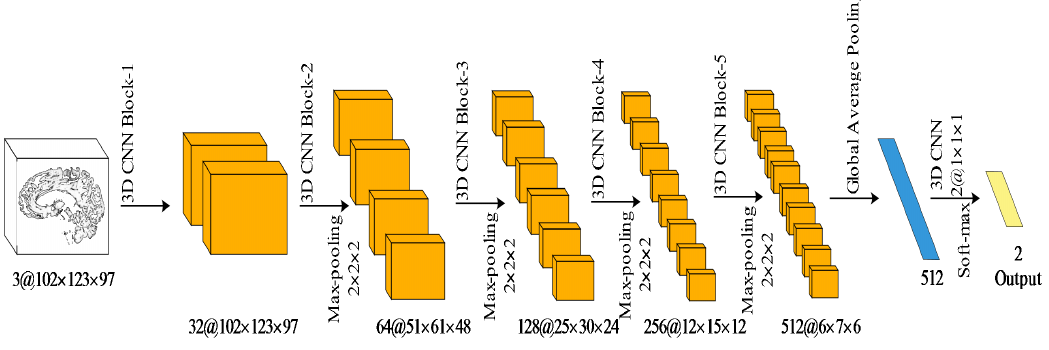
Figure 3. The architecture of classification 3D CNN.